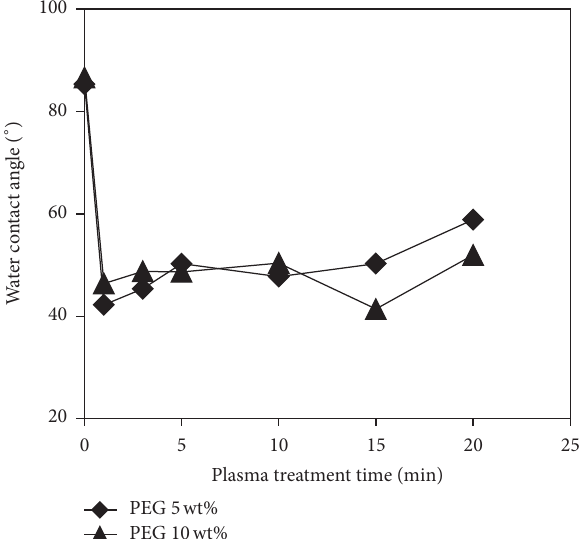
Figure 7: Water contact angle of PSF/PEG membranes after being treated with low temperature DC Ar-plasma at treatment time of 0, 1, 3, 5, 10, 15, and 20 min.